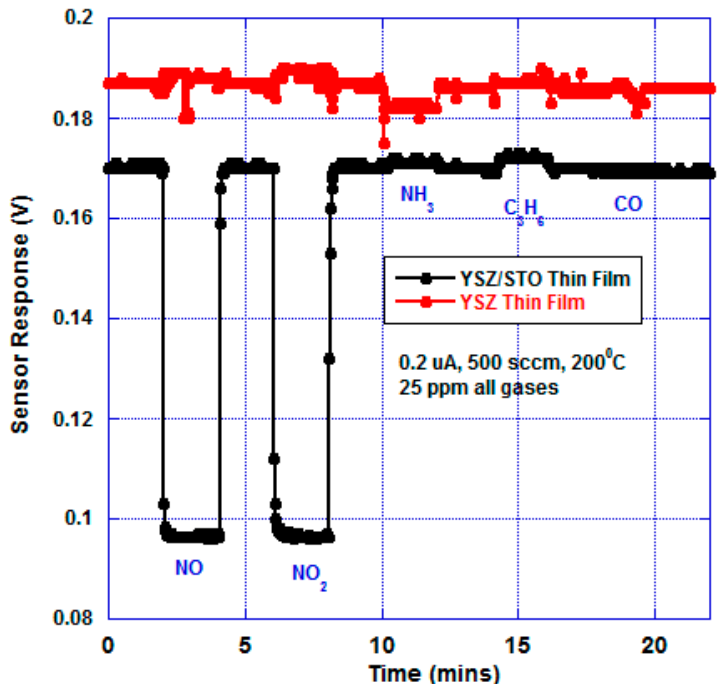
Figure 5. Current-biased mixed-potential sensor response to various analytes (25 ppm) at 200 °C, 500 sccm, and oxygen partial pressure of 21%. The sensor made with a YSZ/STO thin-film electrolyte showed selective NO x response, whereas the sensor made of just the YSZ thin film showed no response. The letter ‘u’ stands for the symbol ‘µ’. Humidity was not added in this experiment.